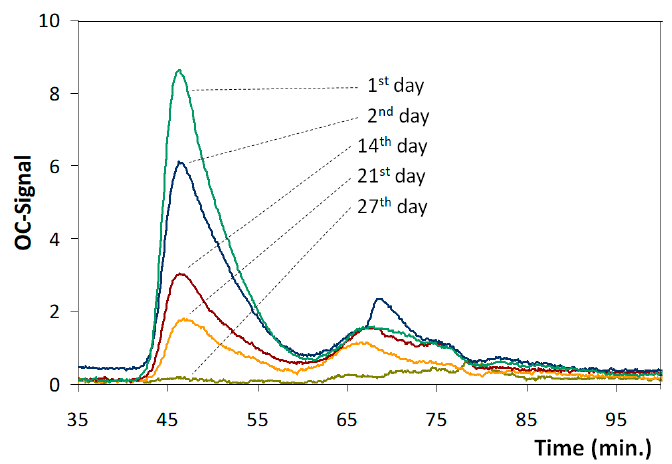
Figure 9. Leaching of Asellus aquaticus feces analyzed with liquid chromatography coupled with organic carbon detection (LC-OCD). The first peak (48 min) corresponds to biopolymers (polysac- charides), the second peak (69 min) represents humic acids, low molecular weight acids and neutral substances do not give a signal (>85 min).